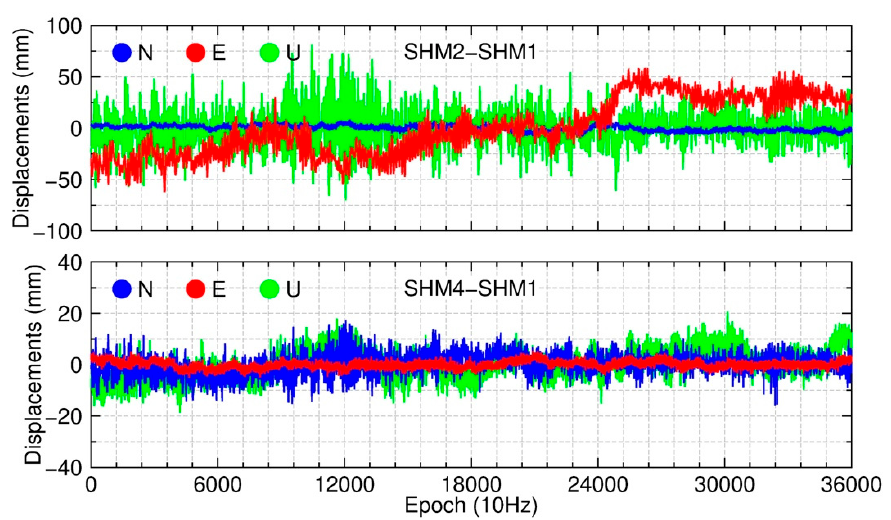
Figure 9. Displacement time series of SHM2 and SHM4.